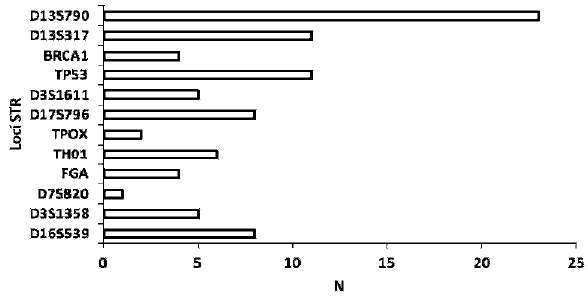
Figure 2 - Distribution of STR instabilities among the loci. The D2S123 locus presented no alterations. N: number of genetic instabilities at each STR locus.